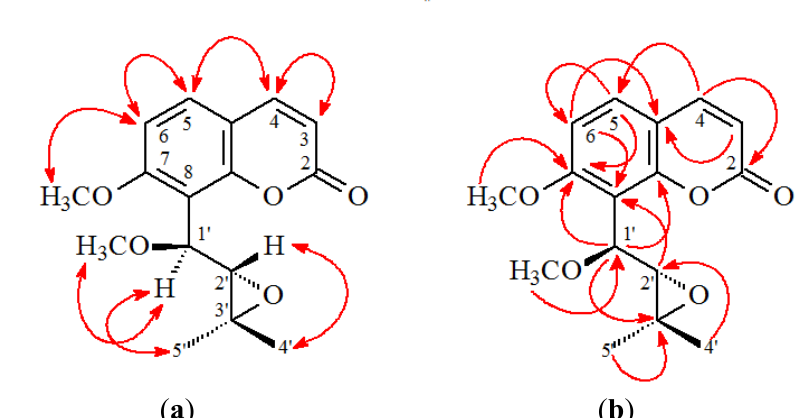
Figure 4. Key NOESY ( a ) and HMBC ( b ) correlations of 2 .